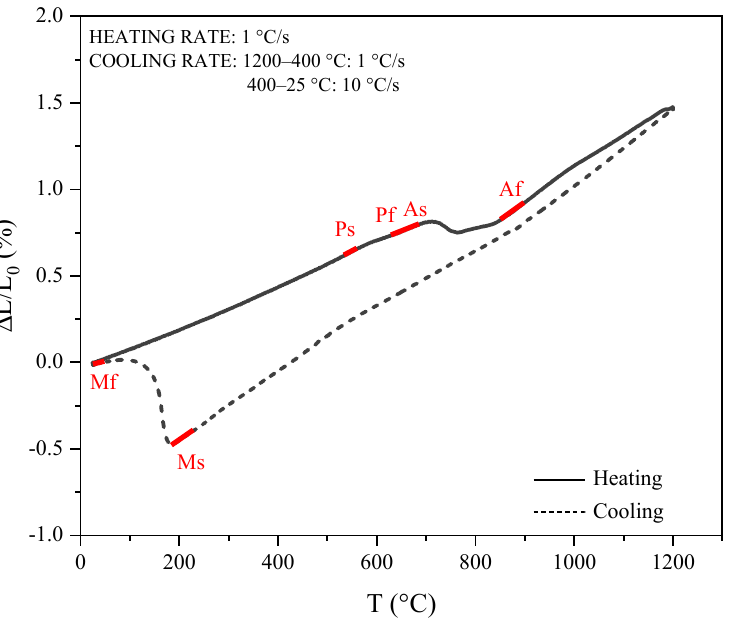
Figure 3. Dilatometry heating and cooling curves for the maraging 13Ni15Co10Mo showing trans- formation temperatures.